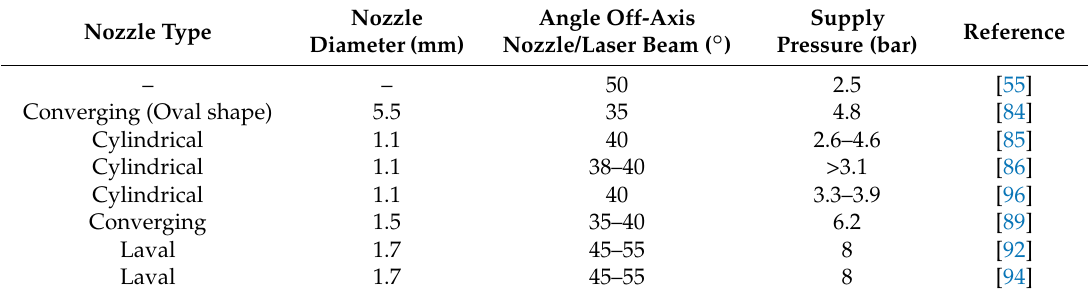
Table 2. Optimal conditions for the off-axis nozzle required for obtaining good quality cuts as proposed by different